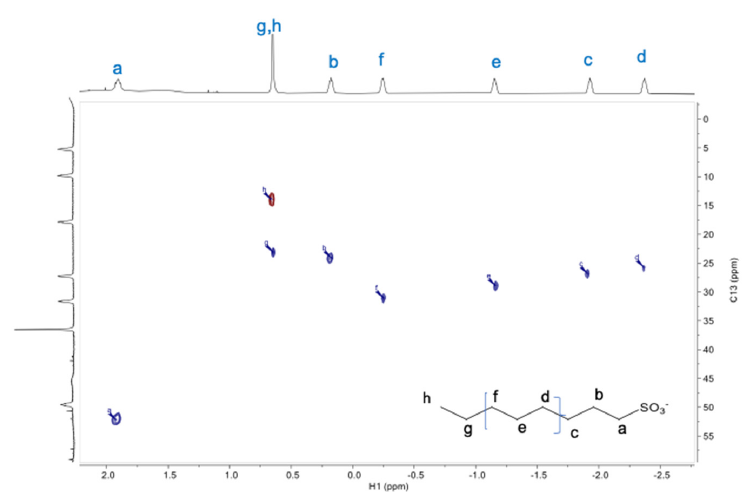
Figure 3. HSQC spectra for a mixture of 1.5 mM of Pillararene and 0.5 mM of octylsulfonate in D 2 O a 25 °C. Labels for octylsulfonate hydrogen atoms are according to the picture shown in the figure.